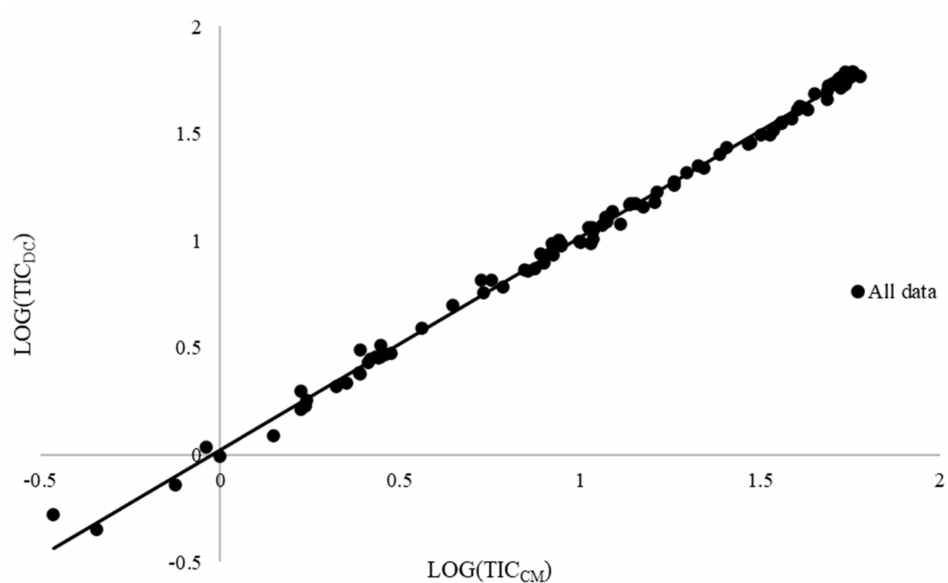
Figure 3. Linear regression between soil total inorganic carbon quantified through calcimeter (TIC CM ) and dry combustion (TIC DC ) methods on the whole data set (n = 117). The fitted equation is TIC DC = 0.99351 TIC CM + 0.02531 (R 2 =